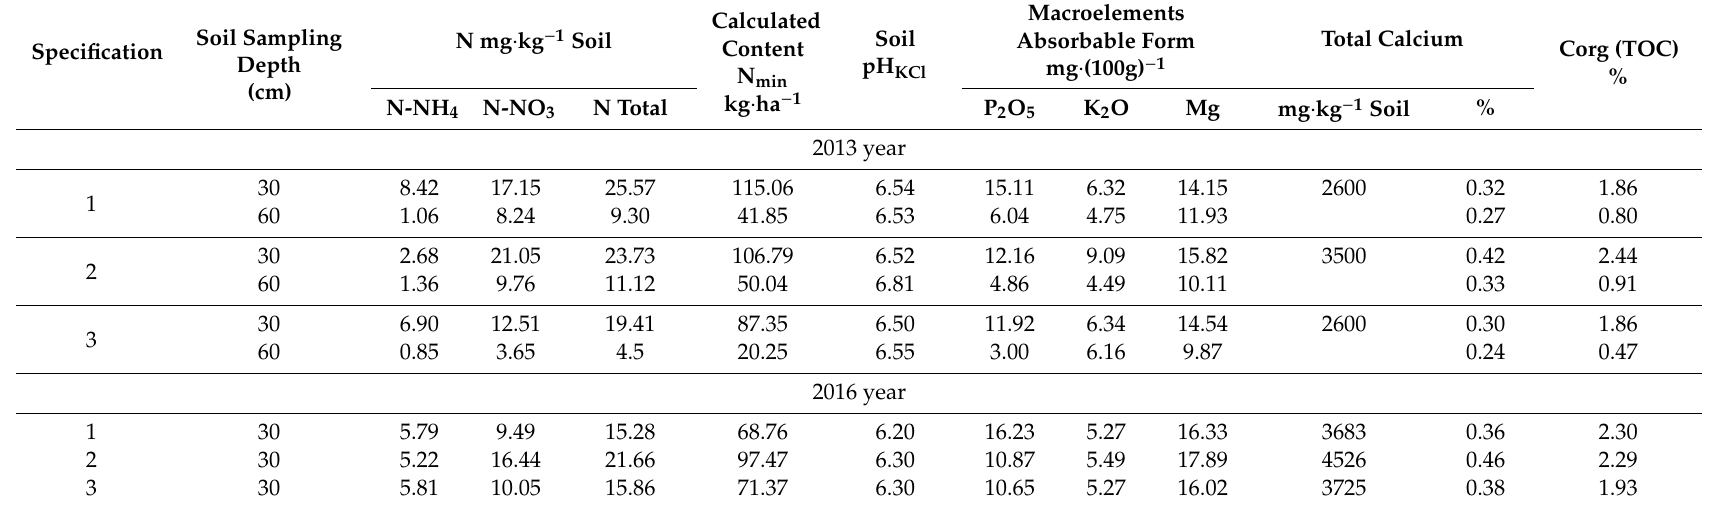
Table 6. Comparison of the content of particular components at two soil depths (30 and 60 cm) before, and at 30 cm after grassland renovation.